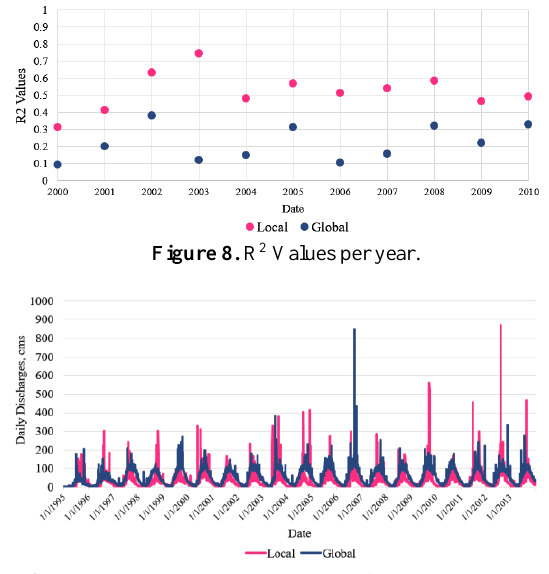
Figure 9. Resulting daily discharges of local weather-based and CFSR-based models.